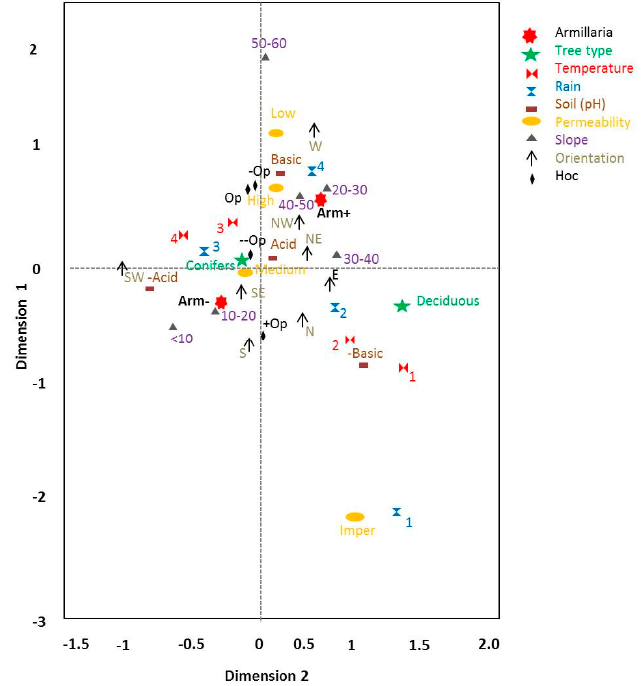
Figure 4. Location in an Euclidean space of the presence or absence of Armillaria spp. and environmental categories. The first two dimensions of the Euclidean space of the MCA are plotted to examine the associations among categories. The values on the axes indicate the coordinates within the Euclidean space in which categories are located. Variable description can be found in Table